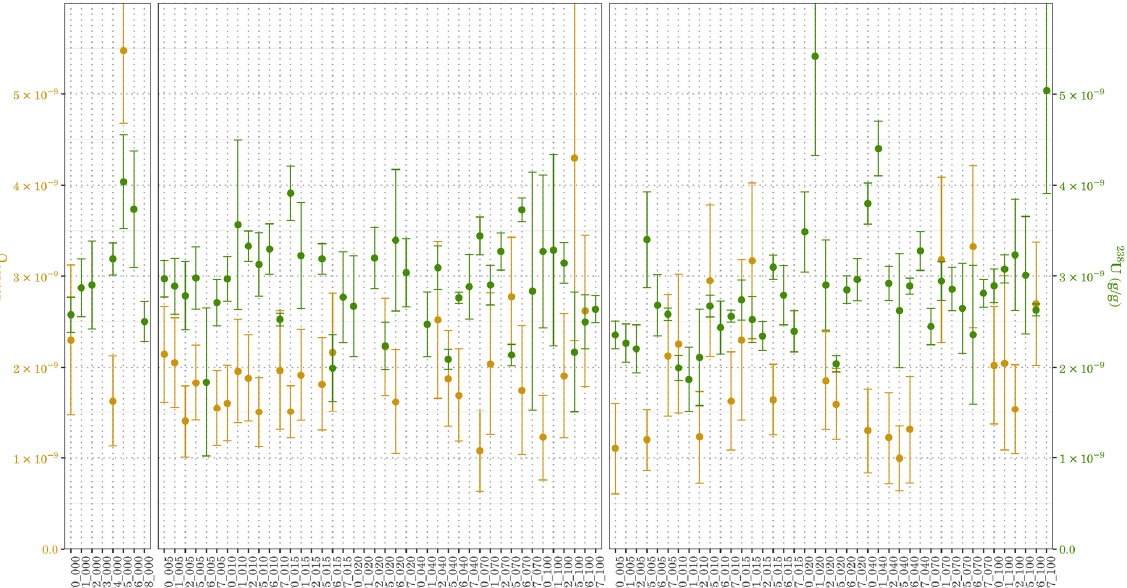
Figure 9. 236/238 U isotopic ratio (in orange, on the left) and 238 U concentration (in green, on the right) measured in marine waters. They are divided by coastal ( left ), deep waters ( center ), and superficial waters ( right ). The samples in abscissa are arranged by increasing depth of sampling. Values below the detection limit are not